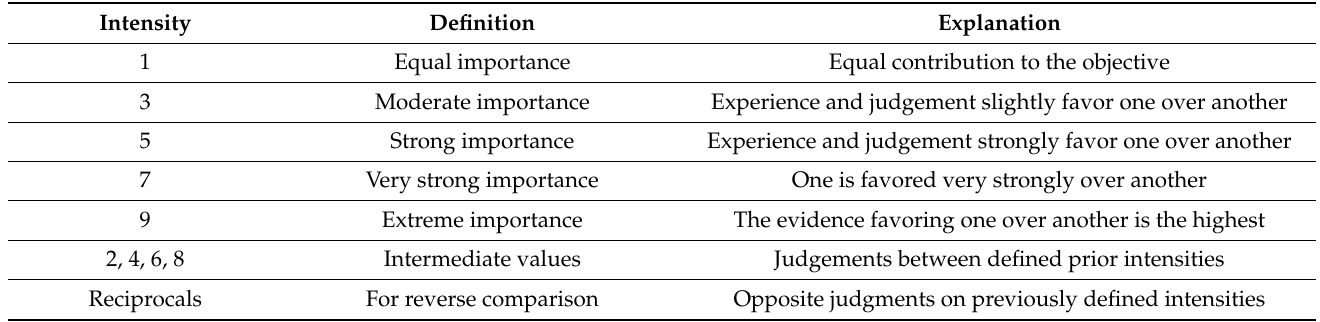
Table 3. Saaty Scale for AHP method.